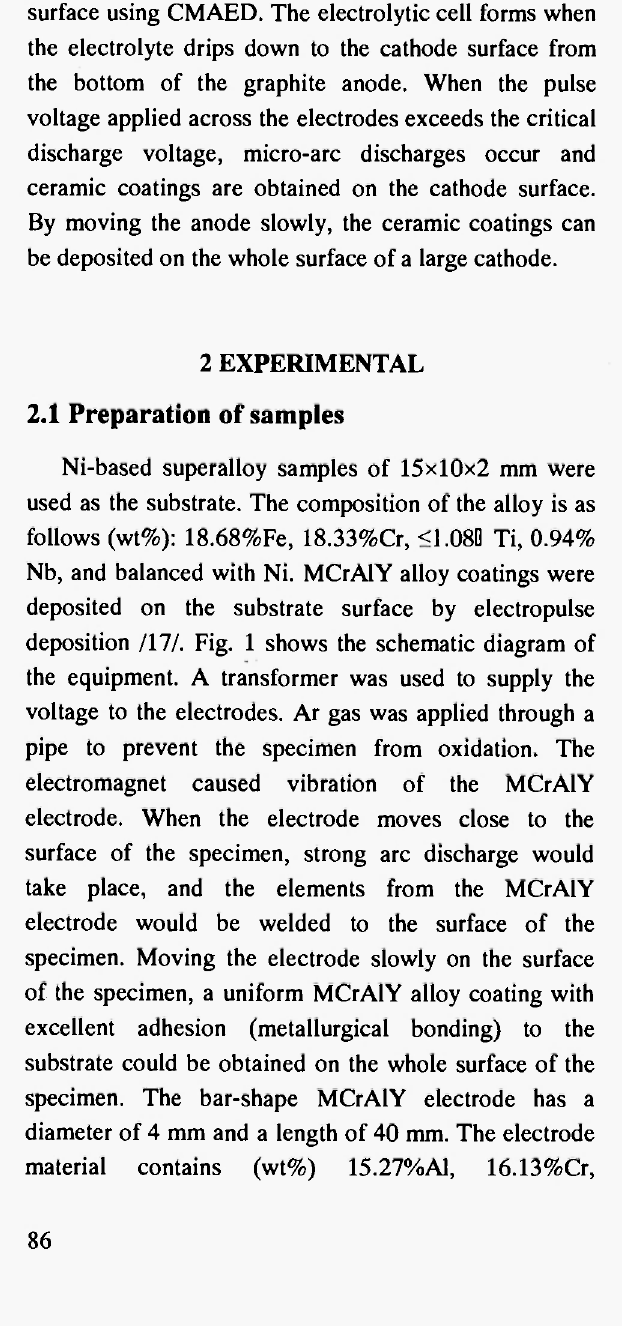
Fig. 1: Schematic diagram of the electro-pulse deposition equipment: 1. elastic steel plate, 2. rubber tube, 3. copper tube, 4. insulating gasket, 5. AC arc welding machine, 6.